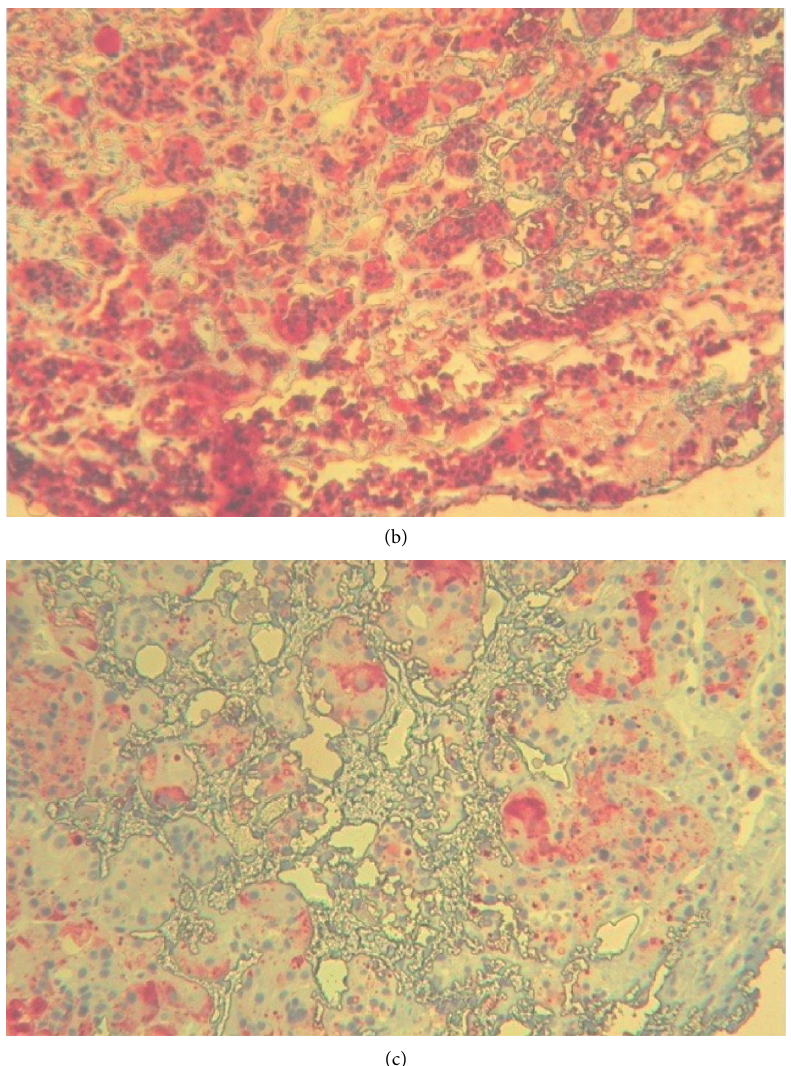
Figure 3: Histopathological and immunohistochemical study showing (a) histopathological features of pituitary adenoma (x200), (b) 50% of ßTSH immunoreactivity (x400), and (c) 25% of prolactin immunoreactivity